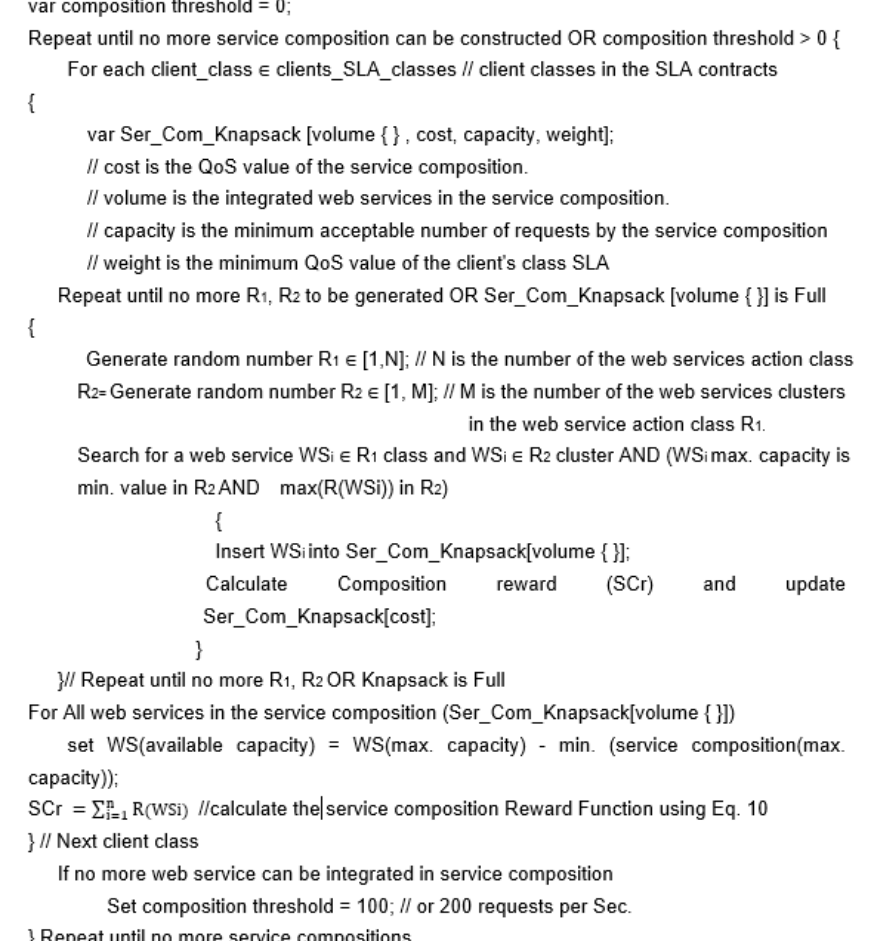
Table 1. Hybrid service-oriented architecture simulator setup parameters.